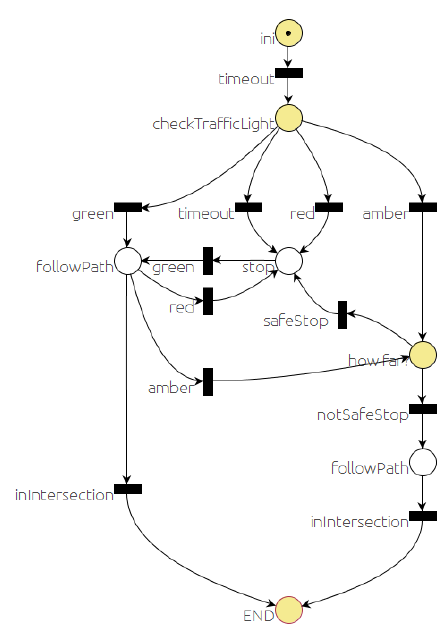
Figure 8. Traffic light behavior PN.